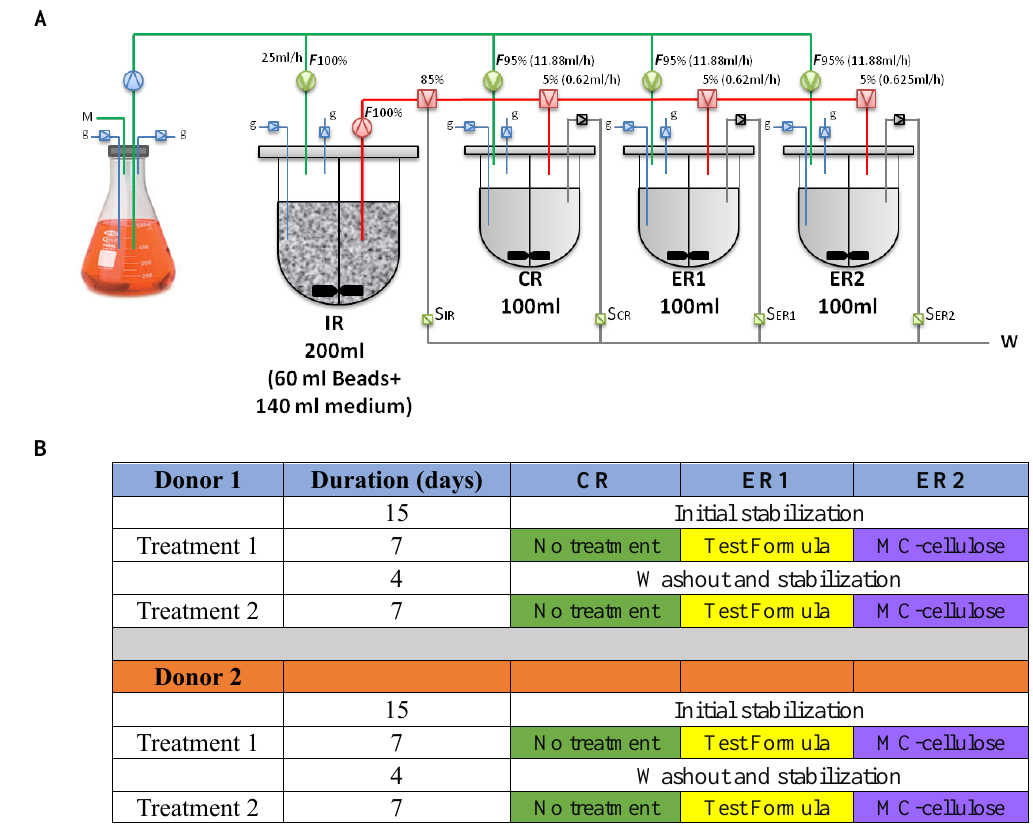
Figure 1. Experimental set up ( A ) and timeline ( B ) of the employed ex vivo colon continuous fermentation model. The gut microbiota was propagated in the inoculating reactor (IR) for 15 days before seeding three sub-reactors (CR no treatment control, ER1 with microcrystalline cellulose control, and ER2 with test sample). M; Nutritive medium, g; pH and dissolved oxygen sensors, W; waste, F; percentage of the medium input (green lines) or inoculum input (red